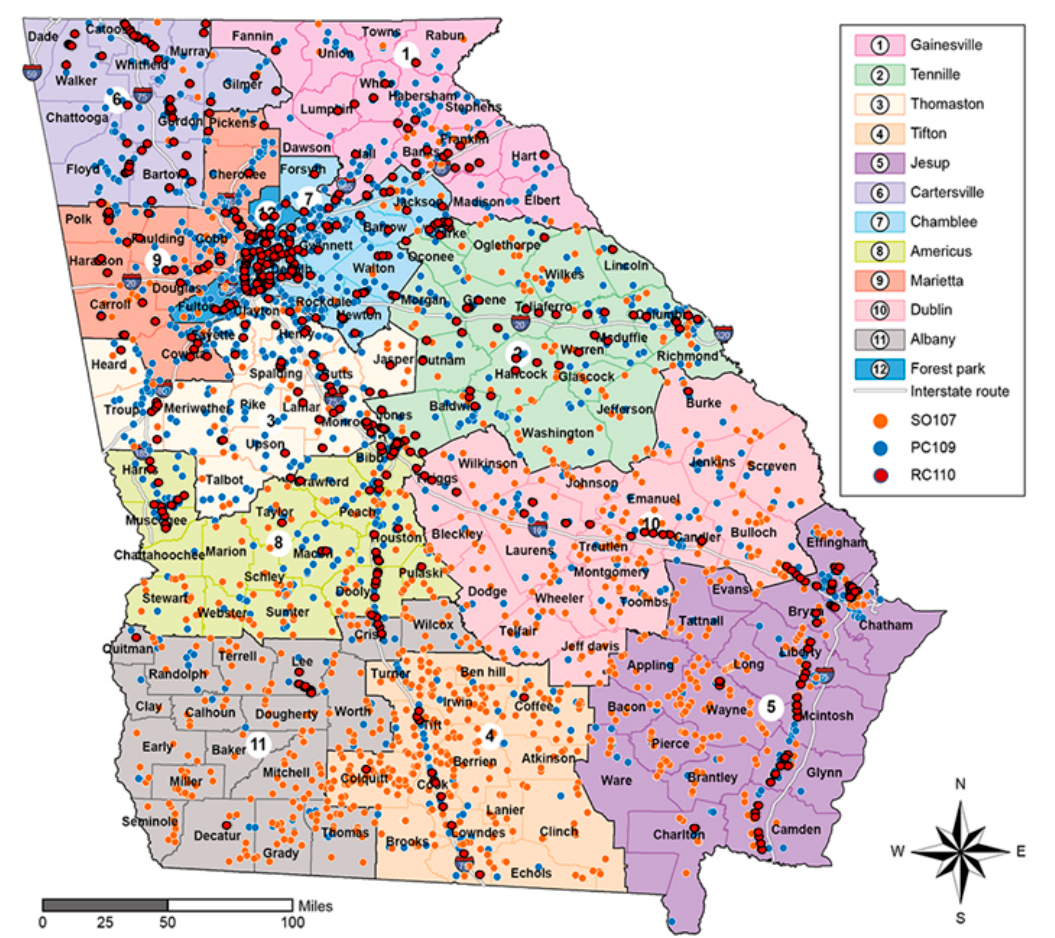
Figure 3. Geographical locations of the identified bridge groups (SO107, PC109, and RC110) in twelve (12) inspection areas in Georgia. Notes: SO107 = Steel open girder / beam bridge; PC109 = Prestressed concrete girder / beam bridges; RC110 = Reinforced concrete open girder / beam bridge. Table 1. A typical element-level inspection in Georgia (reinforced concrete deck for age bin